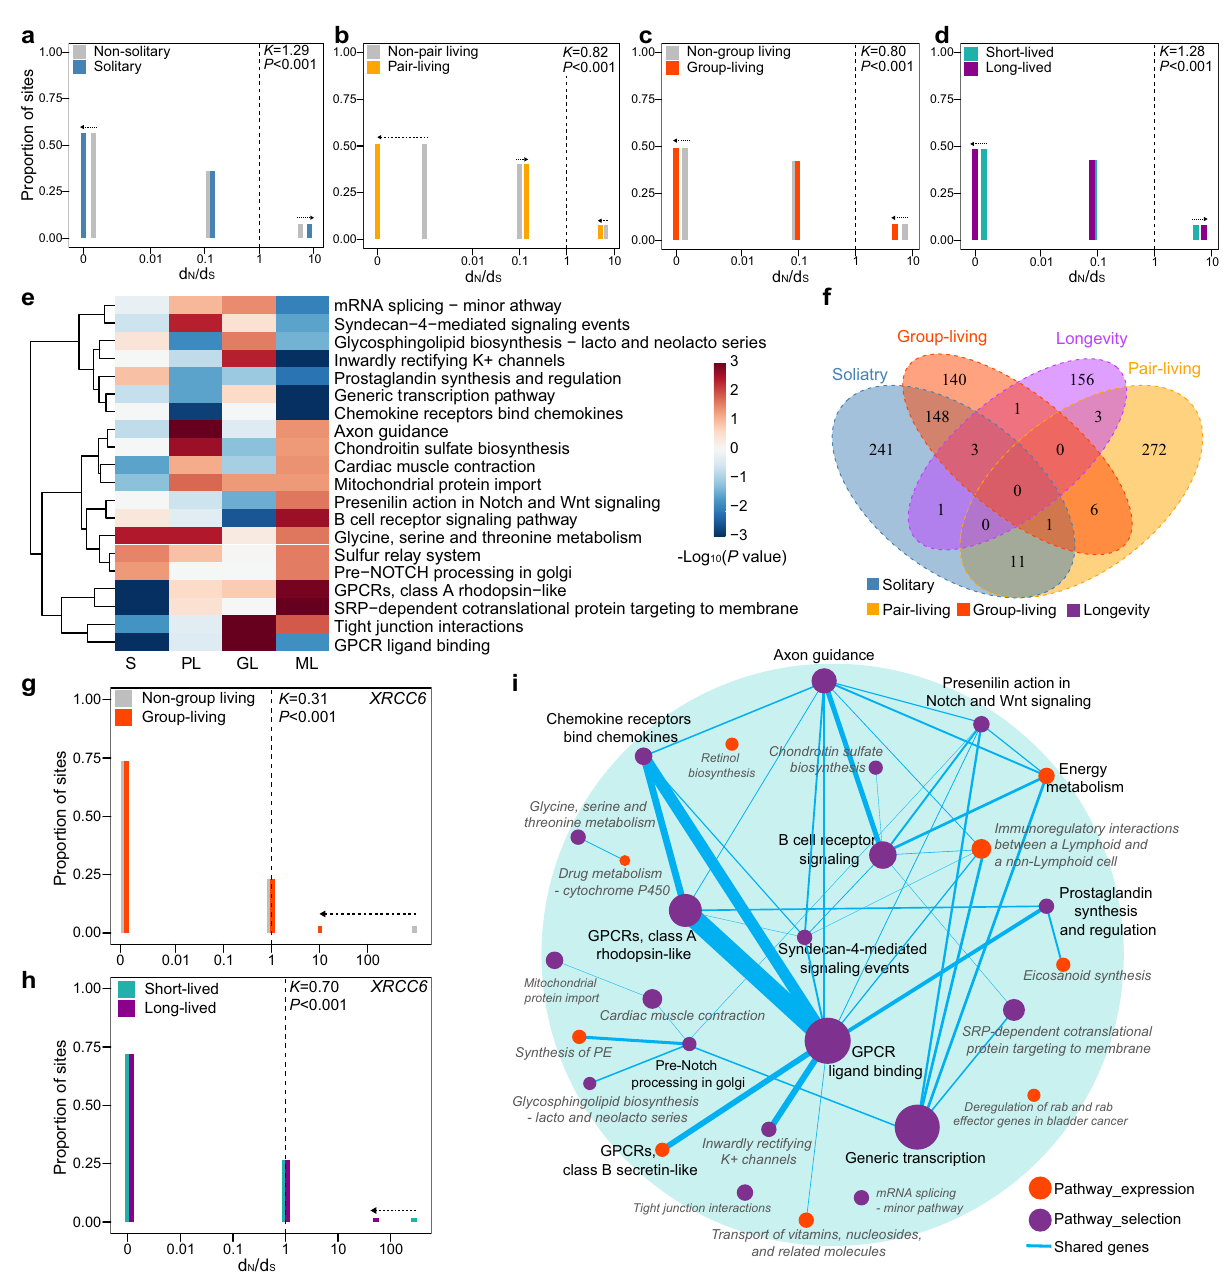
Fig. 3 | Cross-talk between expression and selection in social organization and longevity. The pattern of selection characterizing social organization identi fi ed withaRELAXanalysis(species: n =94): a solitaryspecies, P =1.95×10 − 7 , b pair-living species, P =5.89×10 − 6 , c group-living species, P =5.81×10 − 7 , and d longevity, P =6.76×10 − 7 . P value was calculated using Likelihood-ratio test (LRT). K <1 indi- cates relaxed selection and K >1 indicates intensi fi ed selection. Genes were under purifying selection when d N / d S <1 and positive selection when d N / d S >1. Arrows represent the d irection of change in d N / d S . The median value of the proportion of sites is shown with a bar plot. Social organization and longevity are colored as follows: solitary: blue; pair-living: orange; group-living: red; short-lived state: cyan; and long-lived state: purple. e A heat map of signi fi cant pathways that ov e